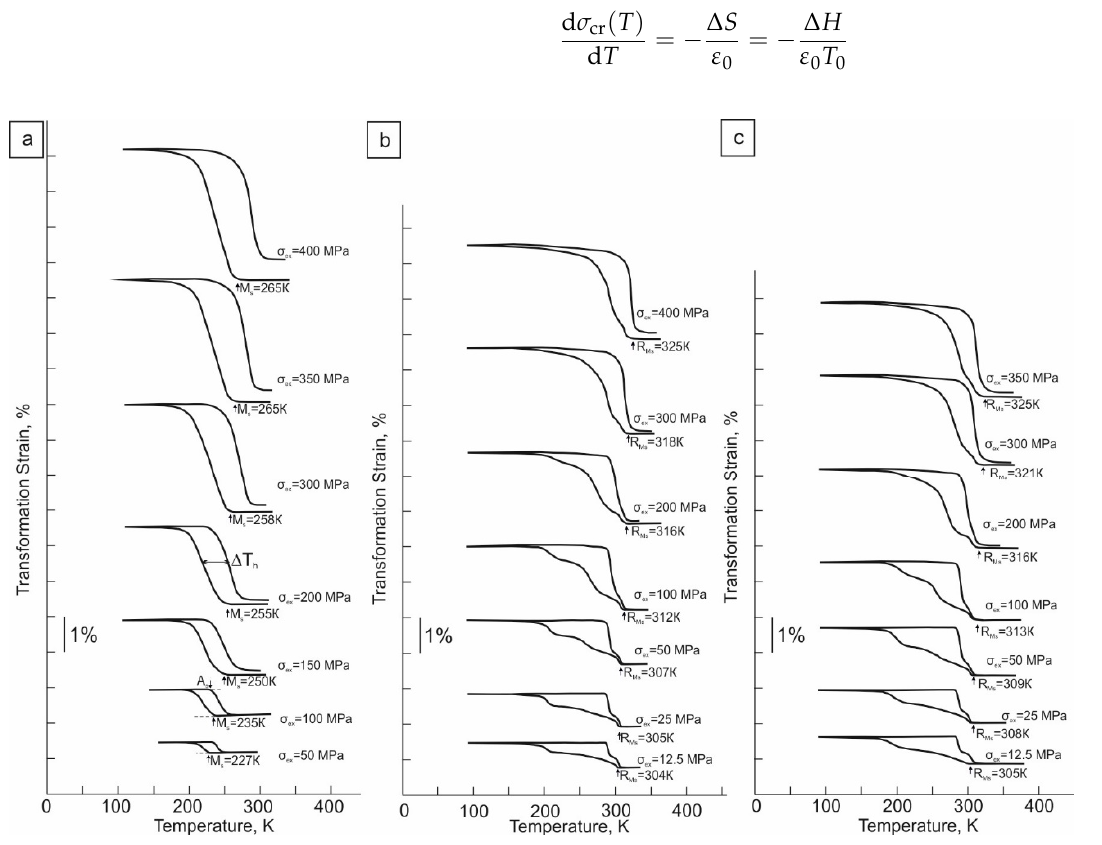
Figure 3. Change in the magnitude of the shape memory effect with increasing compressive stresses of the [011]-oriented Ti-50.1Ni single crystals: ( a )—quenching; ( b )—annealing at 713 K for 0.5 h in helium gas; ( c )—annealing at 713 K for 0.5 h in dry air.